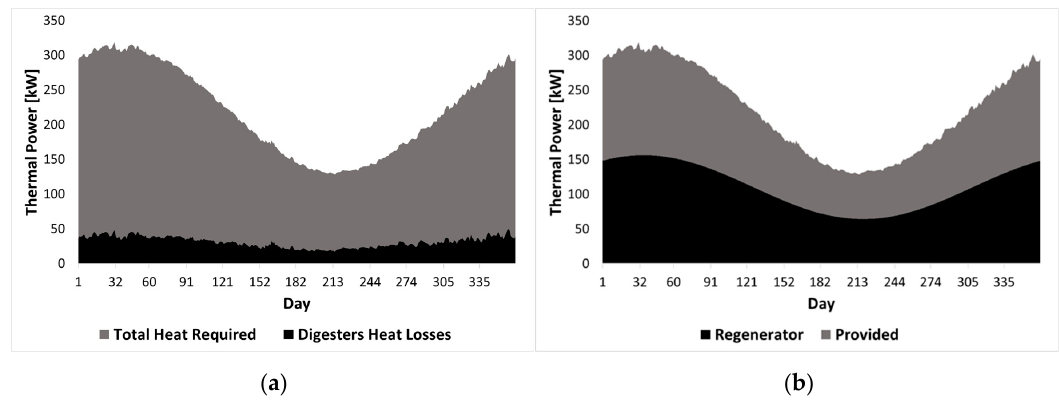
Figure 8. The total heat required and digester losses ( a ) and the heat recovered in the regenerator ( b ).